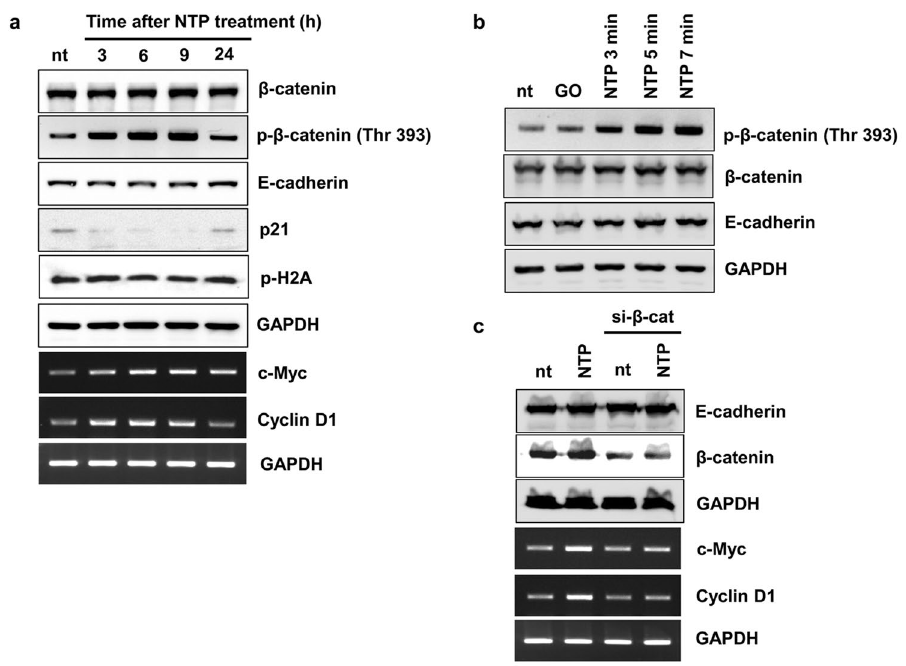
Figure 3. The effect of NTP on β -catenin expression in confluent HaCaT cells. ( a ) The results of Western blot and RT-PCR. Confluent HaCaT cells were treated with NTP for 5 minutes at 3, 6, 9, 24 hours before harvesting. ( b ) Confluent HaCaT cells were treated with NTP for the indicated length of time and incubated for 6 hours. After harvesting the cells, the total protein extracts were used for Western blot analysis. GO: Gas only (argon). ( c ) One day after seeding, HaCaT cells were transfected with scrambled siRNA (sc) or siRNA against β -catenin. Six hours before harvesting, cells were treated, or not, with NTP for 5 minutes. After harvesting, the total RNA and protein extracts were used for RT-PCR and Western blot analysis, respectively. Data shown are representative of three independent experiments. GAPDH was used as loading control. All images presented here are the cropped images (see Supplementary information for the original